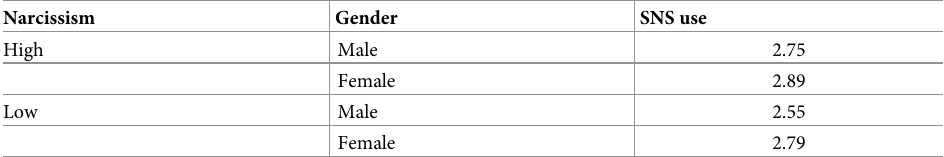
Table 2. Social media use (SNS use) by narcissism and gender.